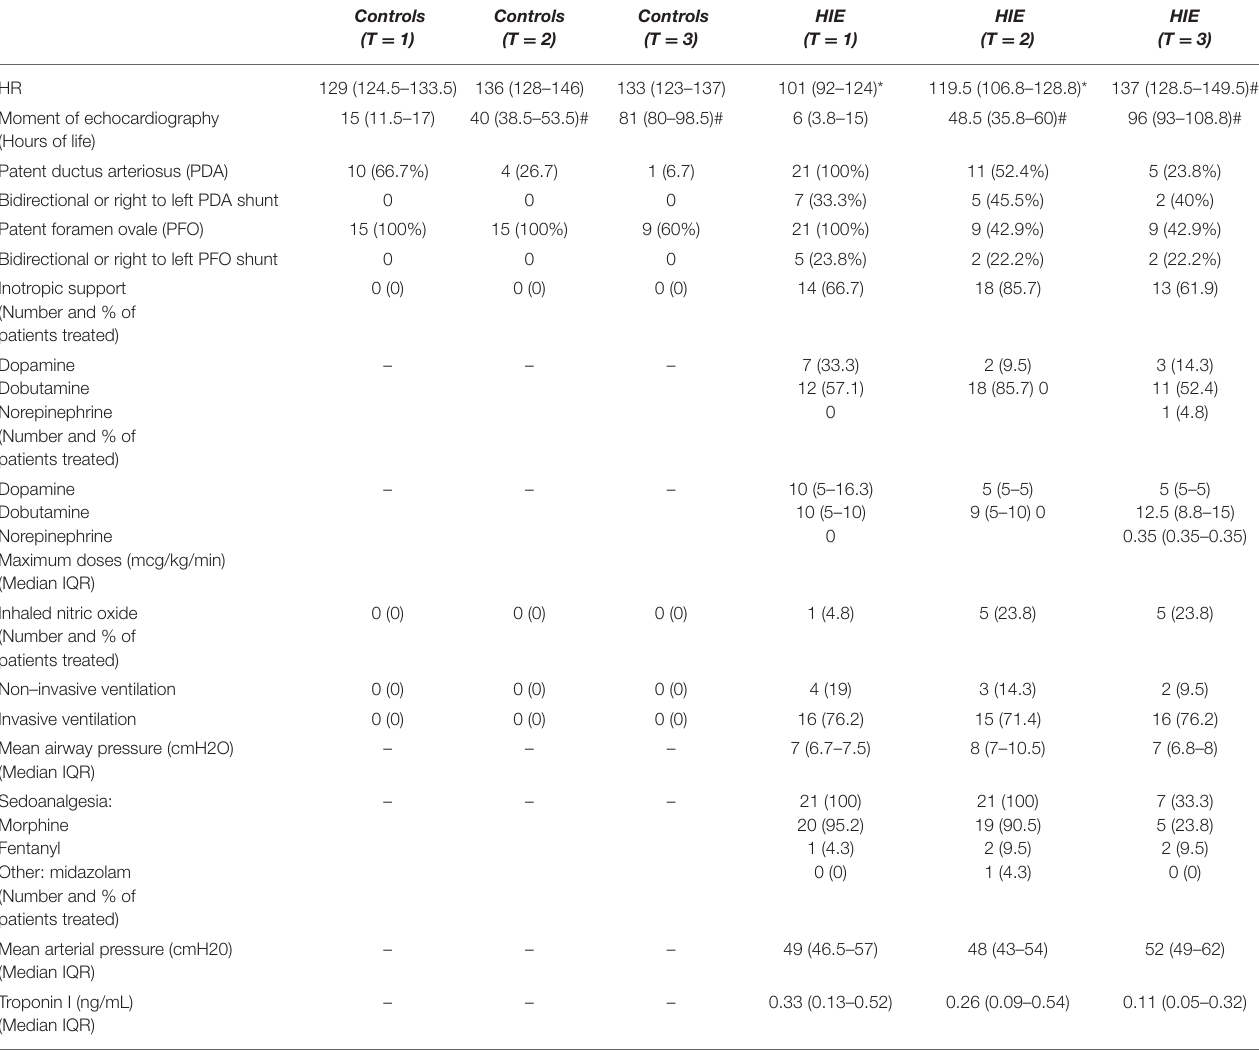
TABLE 2 | Clinical and echocardiographic data of patients included in the